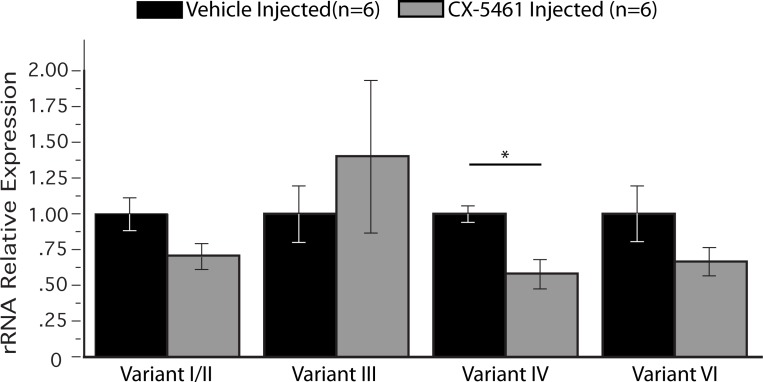
Pol I inhibition before and during training prevents learning-induced upregulation of rRNA Variant IV.Real-Time qPCR samples derived from dorsal hippocampi collected 1 h after APA training taken show that CX-5461 only significantly inhibits the rRNA variant IV after training. t10 = 3.96; *p<0.01.